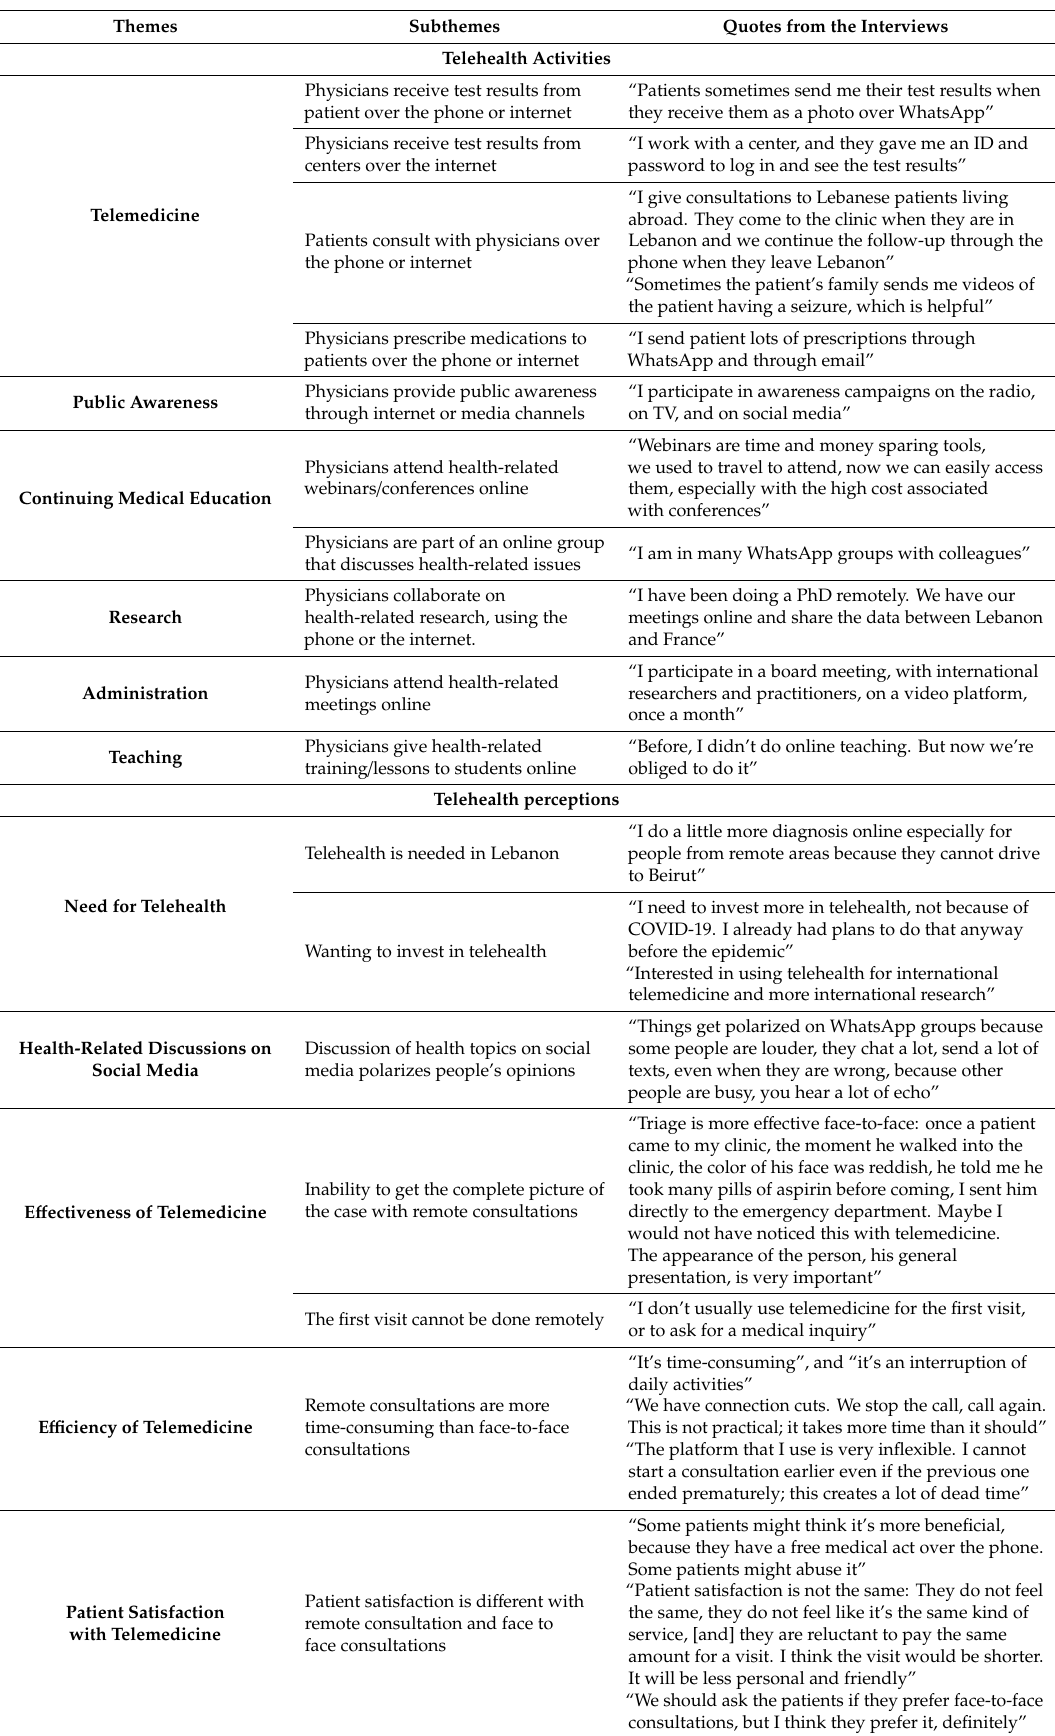
Table 1. The list of themes, subthemes, and supporting quotes from the